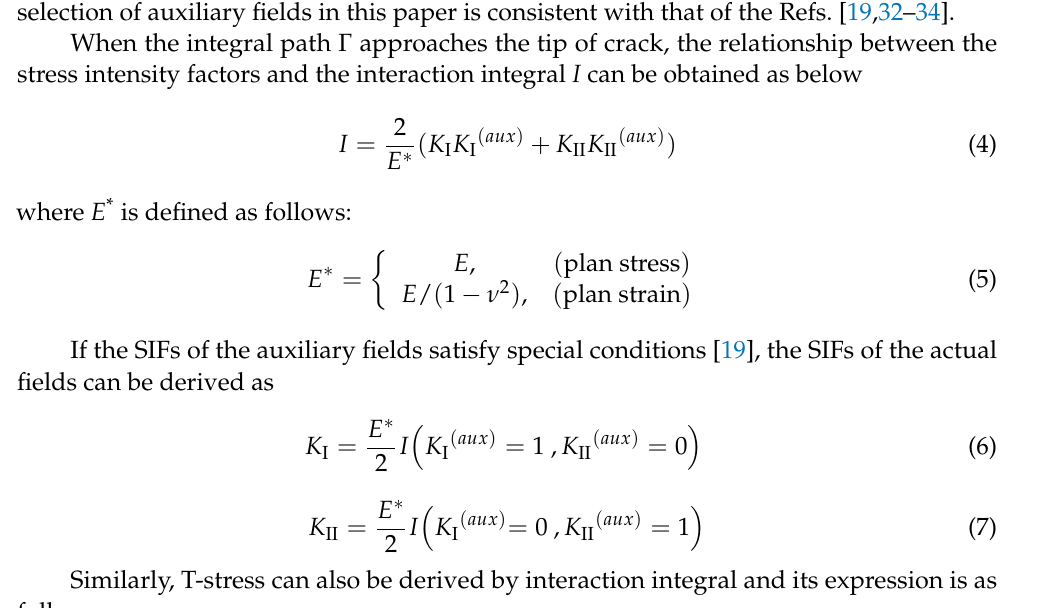
Figure 1. The equivalent surface integral of the interaction integral.